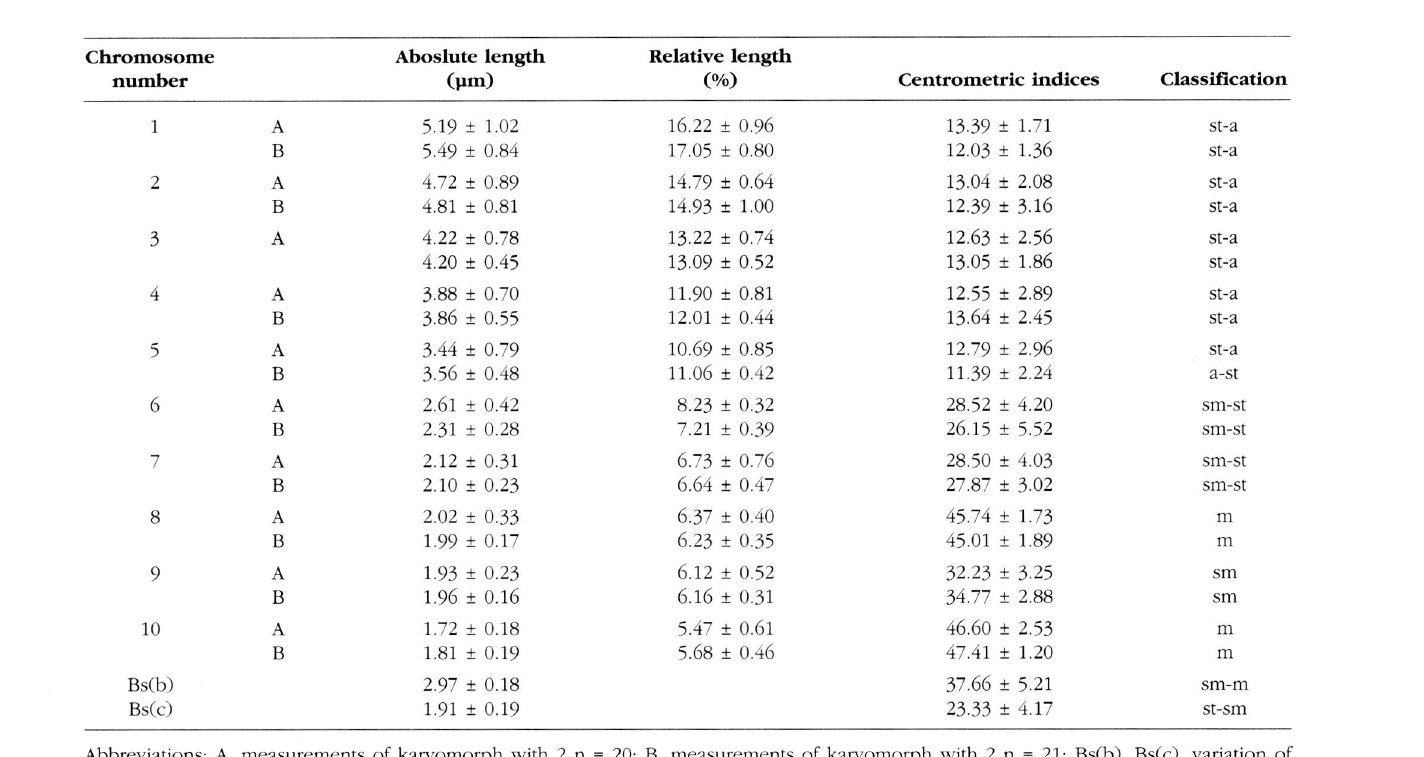
Table I. - Measurements (means ± SD) and classification of two karyomorhs of